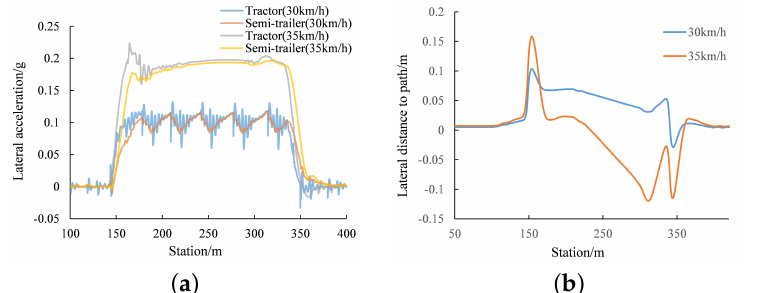
Figure 11. ( a ) Lateral acceleration and ( b ) lateral displacement of tractor-trailer for wind speeds of 74